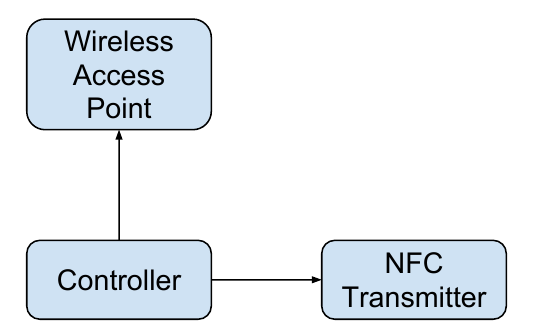
Figure 1. Overall system